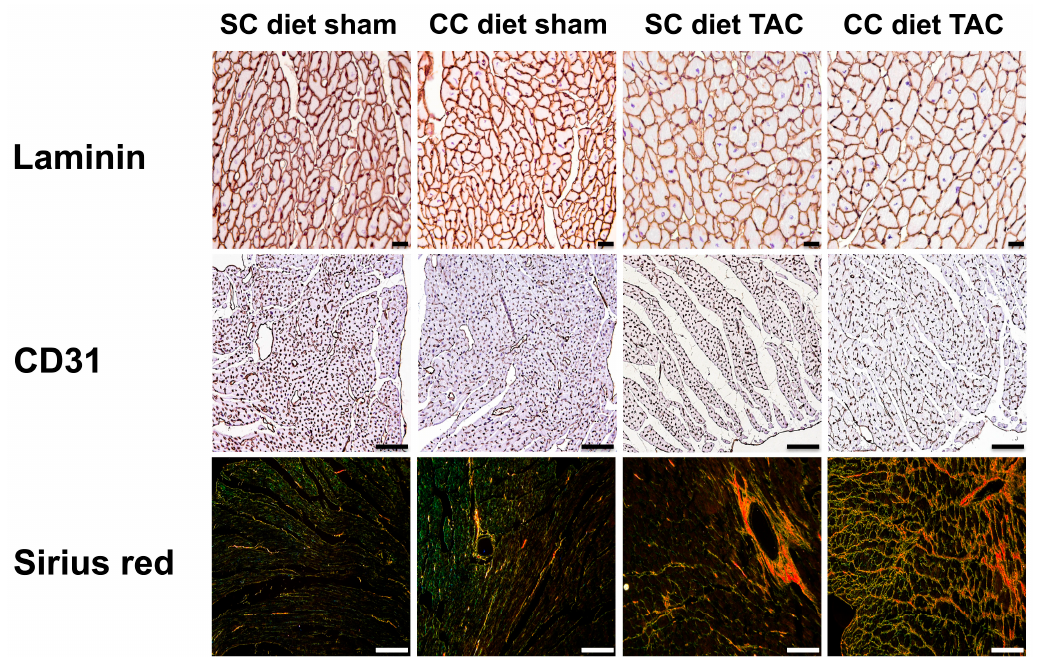
Figure 3. (Immuno) histochemical analysis of the myocardium of sham mice and TAC mice at Day 56 after operation. Representative photomicrographs show laminin-stained cardiomyocytes, CD31-positive capillaries, and Sirius red-stained interstitial collagen viewed under polarized light. Scale bar represents 50 µm.